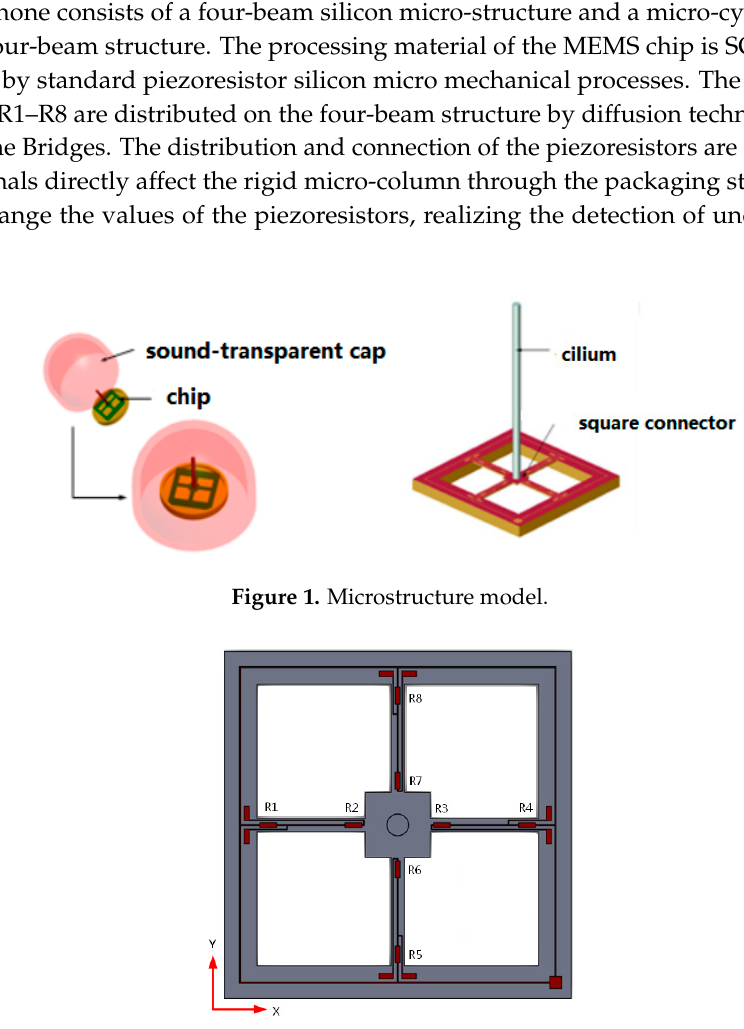
Figure 2. Distribution of the piezoresistors.